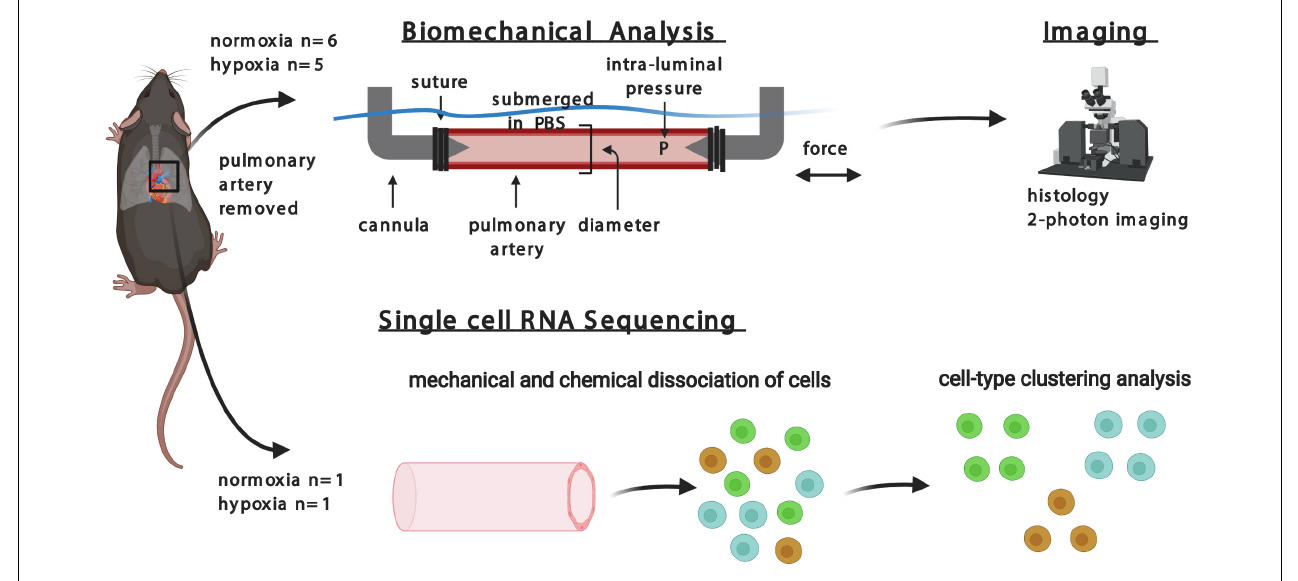
FIGURE 1 | Multi-disciplinary approach to investigating hypoxia in pulmonary artery of